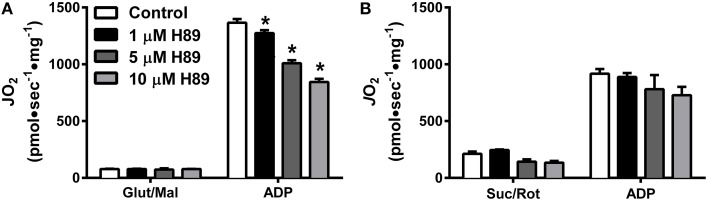
PKA regulates Complex I- but not Complex II-supported respiration in isolated liver mitochondria. JO2 was measured with complex I (A) or complex II (B) supported substrates in the absence (white bars) or presence of 1 (black bars), 5 (dark gray bars), or 10 (light gray bars) μM H89. N = 4–6/condition. * denotes p < 0.05 compared to control.